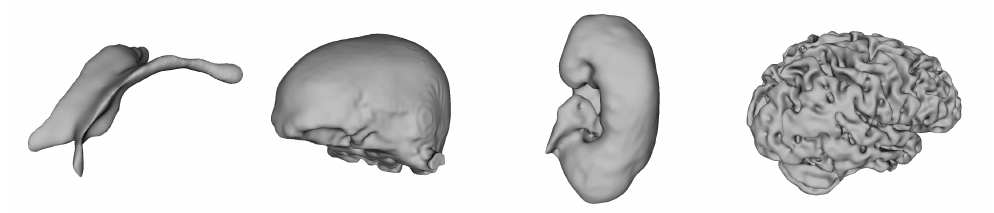
Figure 1. Three-dimensional reconstructed models from MR images used for our